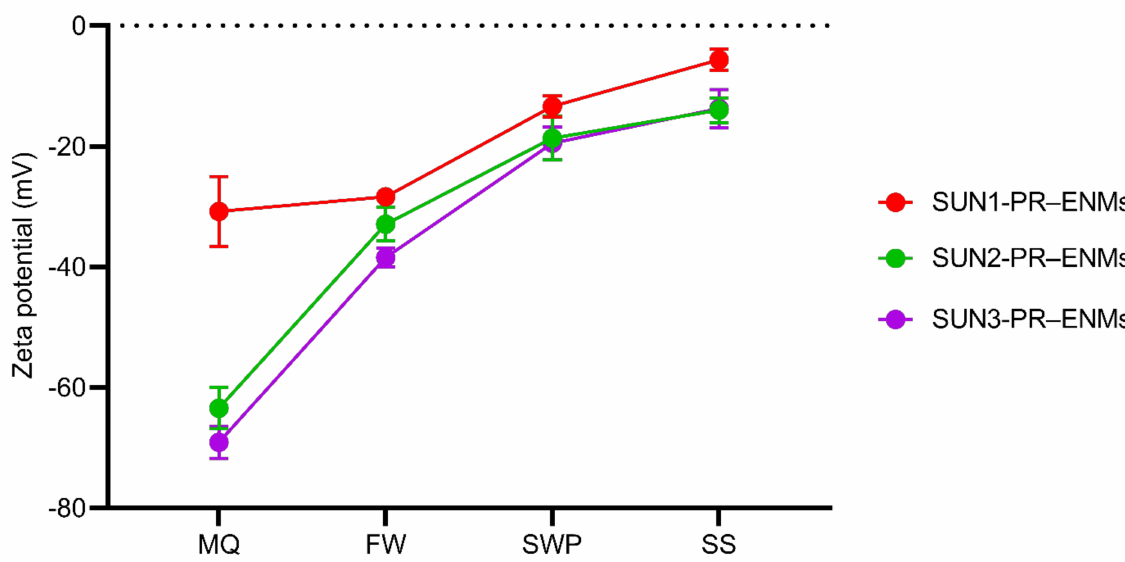
Figure 2. Zeta potential of product-released ENMs (PR–ENMs) obtained under light conditions in different release media of Milli-Q water (MQ), freshwater (FW), swimming pool water (SWP), and seawater